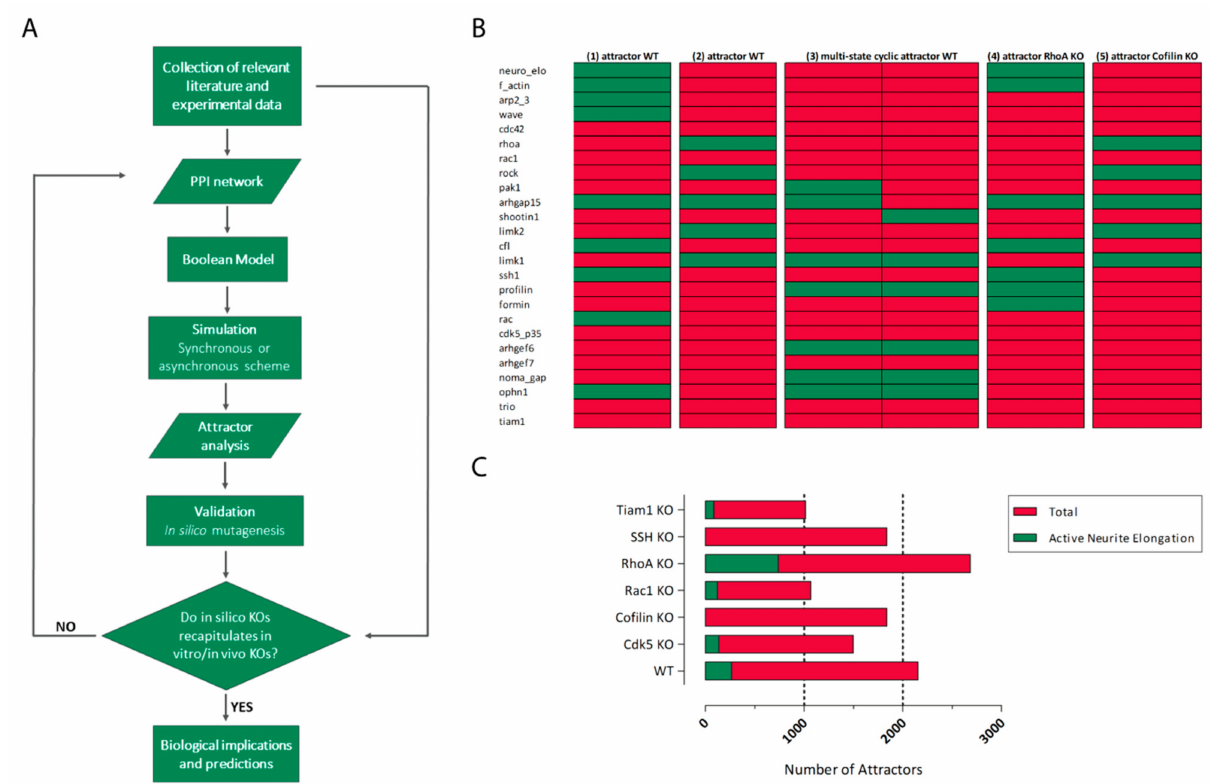
Figure 4. Boolean network. ( A ). Flow chart of the procedure to follow in order to construct a Boolean model. ( B ). Attractor analysis of the Boolean network for the study of neurite extension (Table 1). Comparison of five representative attractor profiles: (1) fixed-point attractor of the WT network (active phenotypic node); (2) fixed-point attractor of the WT network (inactive phenotypic node); (3) multi-state cyclic attractor of the WT network (inactive phenotypic node); (4) fixed-point attractor of the RHOA-KO network (active phenotypic node); (5) fixed-point attractor of the Cofilin-KO network (inactive phenotypic node). Red boxes correspond to inactive nodes and green boxes to active nodes. ( C ). In silico mutagenesis for the validation of the Boolean network (Table 1) using published experimental data from KO models (Table 2). Red bars refer to the total number of attractors obtained. The green part of each bar corresponds to the number of attractors with an active phenotypic node computed over all attractors obtained in each